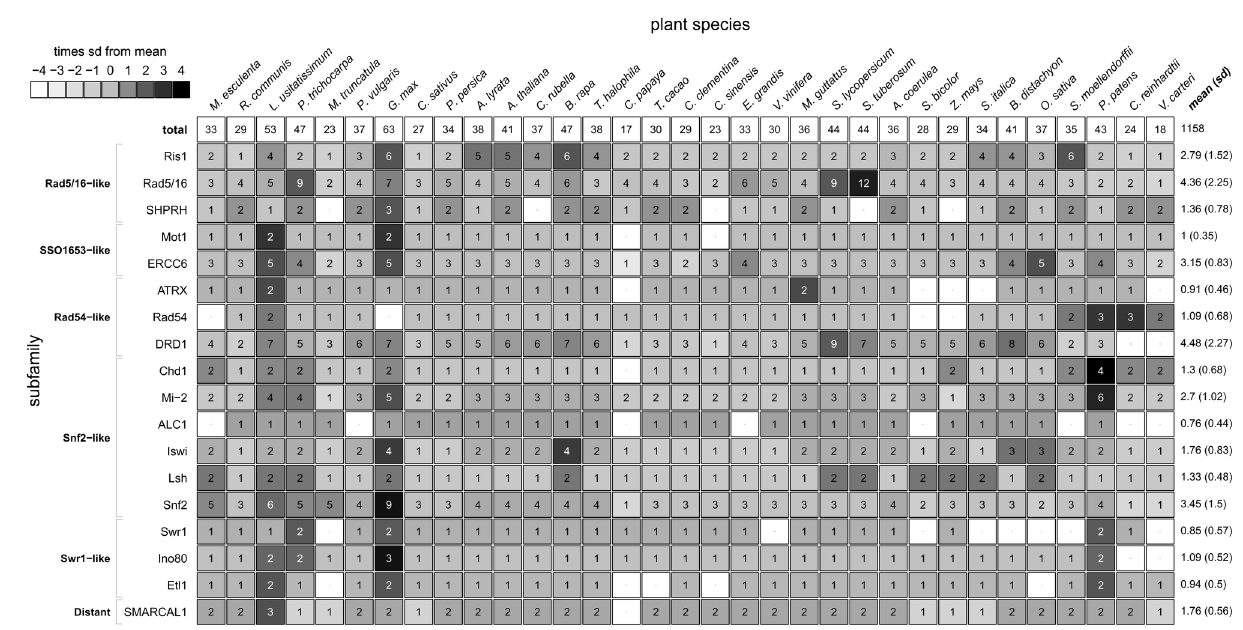
Figure 1. Distribution of Snf2 family members in plant genomes. Groupings and subfamilies on the left are named according to the Arabidopsis subfamily classification [3]. Species names on the top are organized on the basis of their phylogenetic relationship according to Phytozome [14]. Snf2 candidate member Cre09.g390000.t1.1 ( Chlamydomonas reinhardtii ) could not be assigned to any subfamily and was excluded. Subfamily counts are shaded according to the deviation from the subfamily mean in standard deviations (sd). The total count is given on the top right cell. Mean and standard deviations per subfamily are indicated in the last